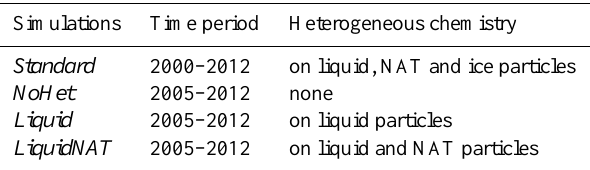
Table 2. The four performed EMAC simulations with different as- sumptions for heterogeneous